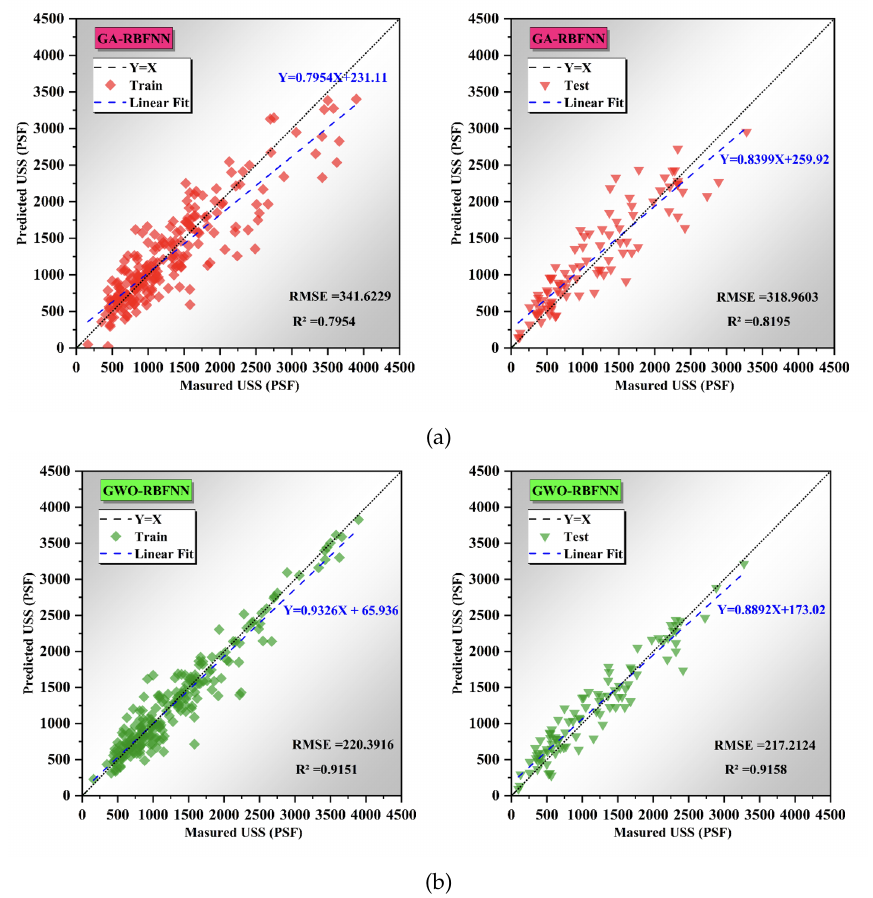
Fig. 7. The scatter plot of between observed and predicted USS for: a) GA-RBFNN; b)